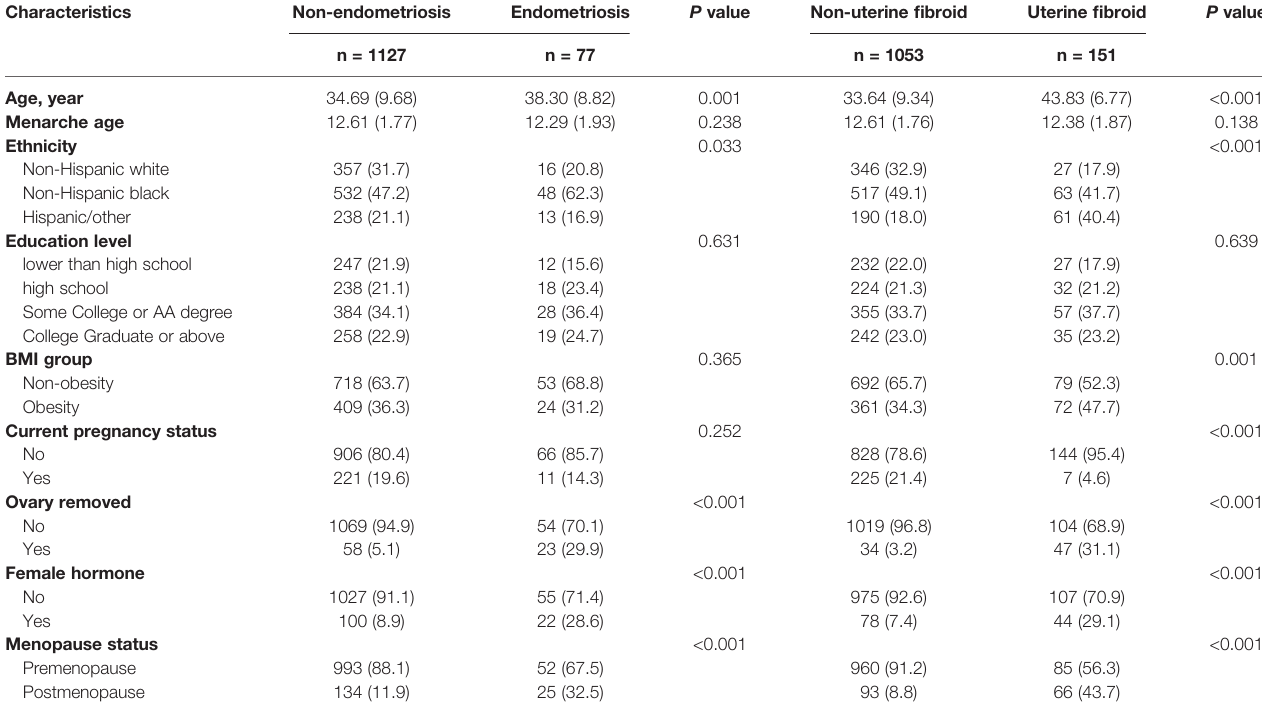
TABLE 1 | Baseline characteristics of the analyzed participants (N=1204).